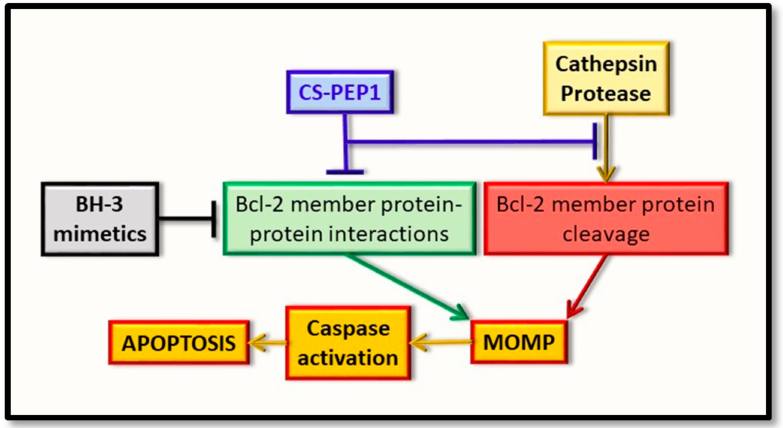
Figure 3. Representation of the early intrinsic arm of the apoptotic pathway, highlighting the key points identified for therapeutic intervention. Whereas BH3-mimetics (black box) can interfere with the pro-apoptotic BH3-domain interaction with the hydrophobic groove of the anti-apoptotic protein (green box), the novel inhibitor (CS-PEP1, blue box) can interfere with cathepsin S-mediated cleavage of the BAX protein (red box) while also potentially interfering with the respective BH3 domain-hydrophobic groove of BAX with Bcl-xL (green box). Consequently, BAX protein can be stabilized in a manner where it can be readily activated for the induction of MOMP and thus enhance apoptosis (orange